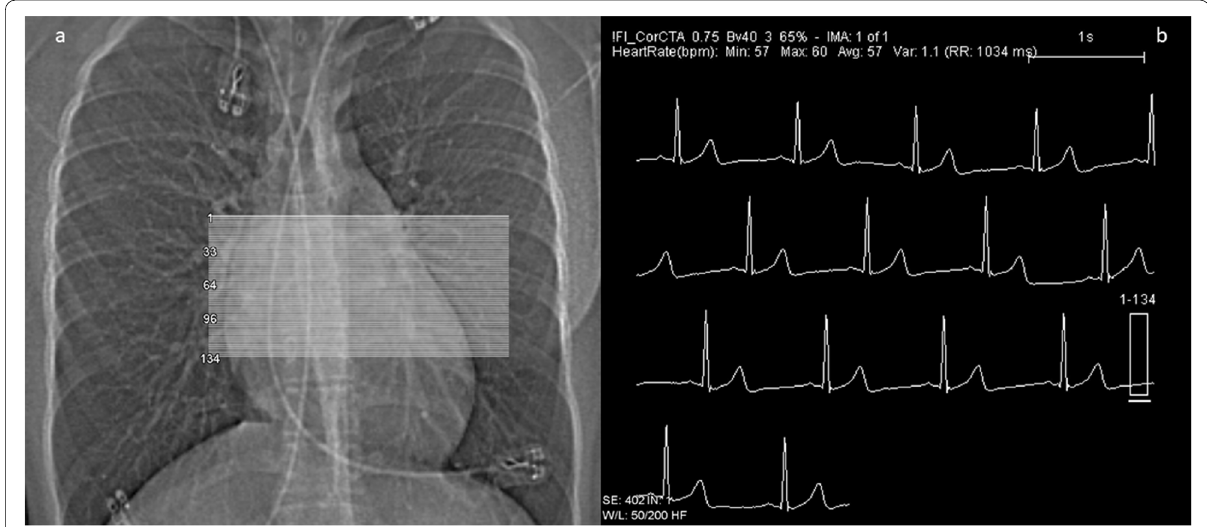
Fig. 2 (Planning and dose monitoring): first steps are a fast low-dose overview (“topogram/sinogram”; left) and a stable ECG monitoring (right) for triggering (prospective mode) or gating (retrospective mode). Figures 2 and 3 derive from the CT of a 15-year-old girl after surgical repair of a malignant coronary anomaly (origin of the left main from the right coronary sinus) with reinsertion of the left main coronary artery with an ultra-low